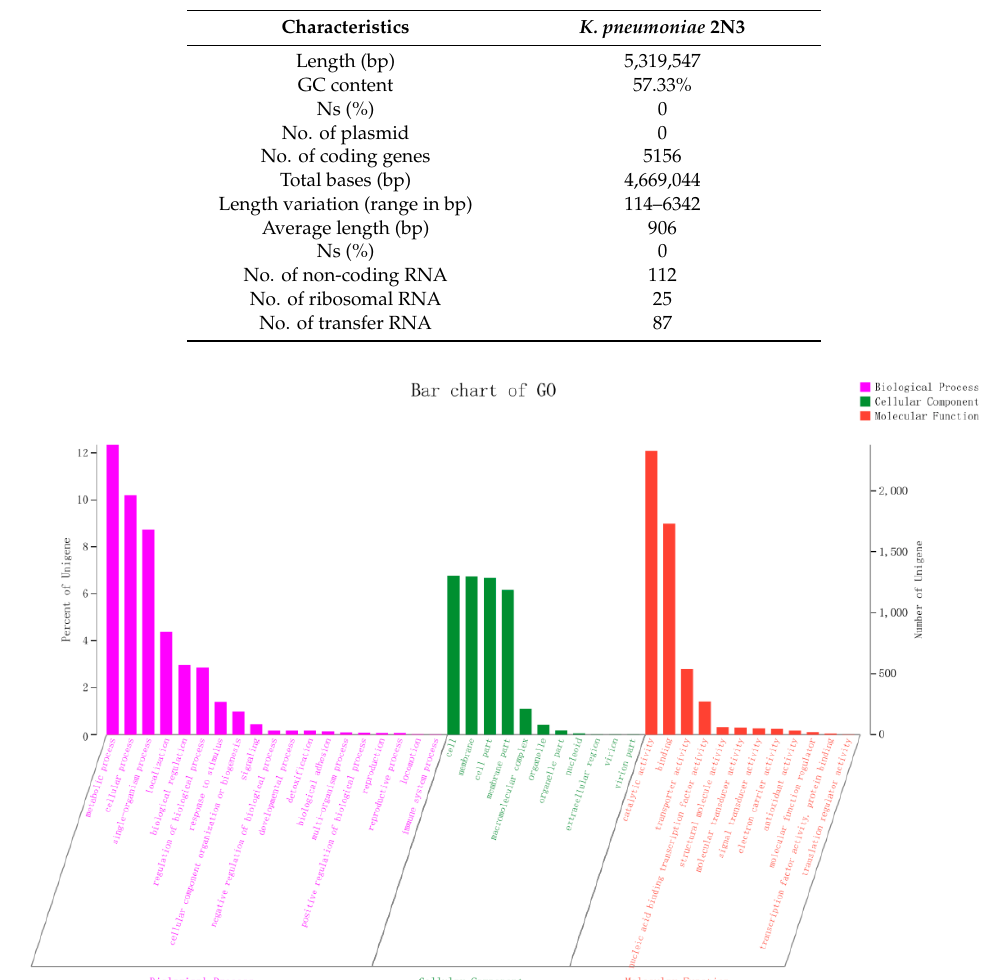
Table 1. Molecular characteristics of the genome of K. pneumoniae 2N3.